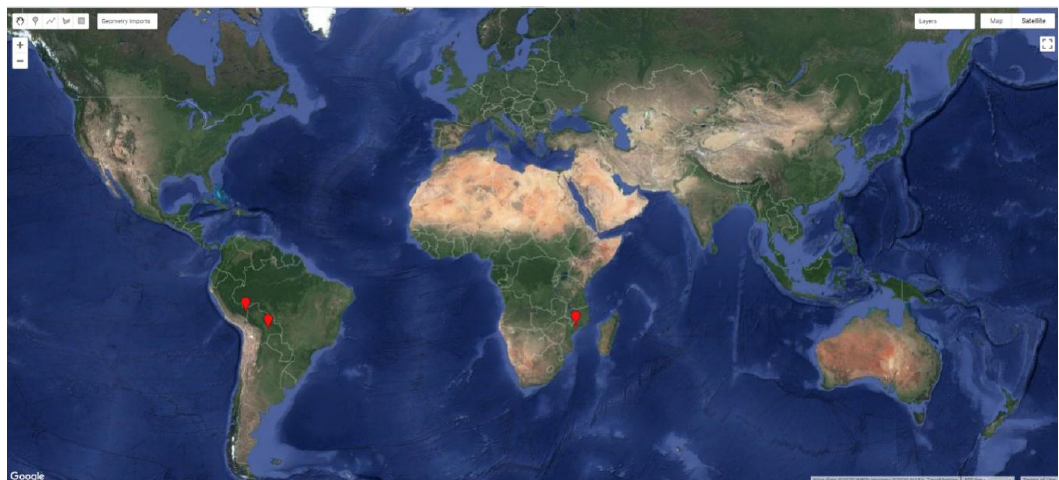
Figure 2. Location of the study sites. The background image is from Google Earth™.